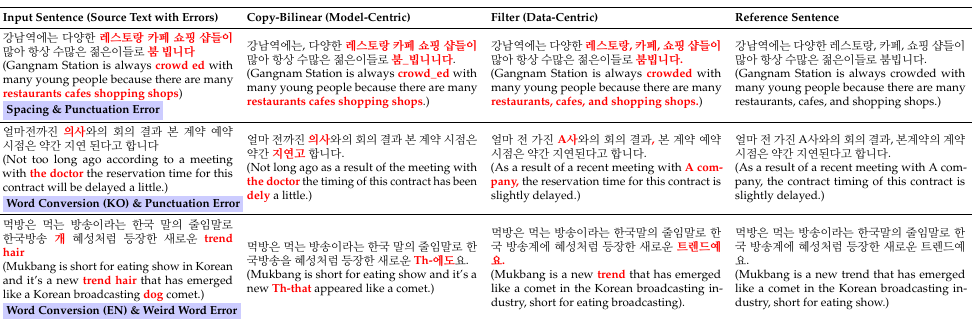
Table 3. Examples of model-centric and data-centric outputs for qualitative